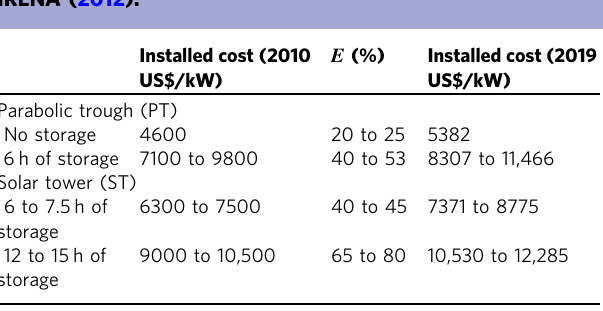
Table 1 CSP costs and performances in 2011 according to IRENA